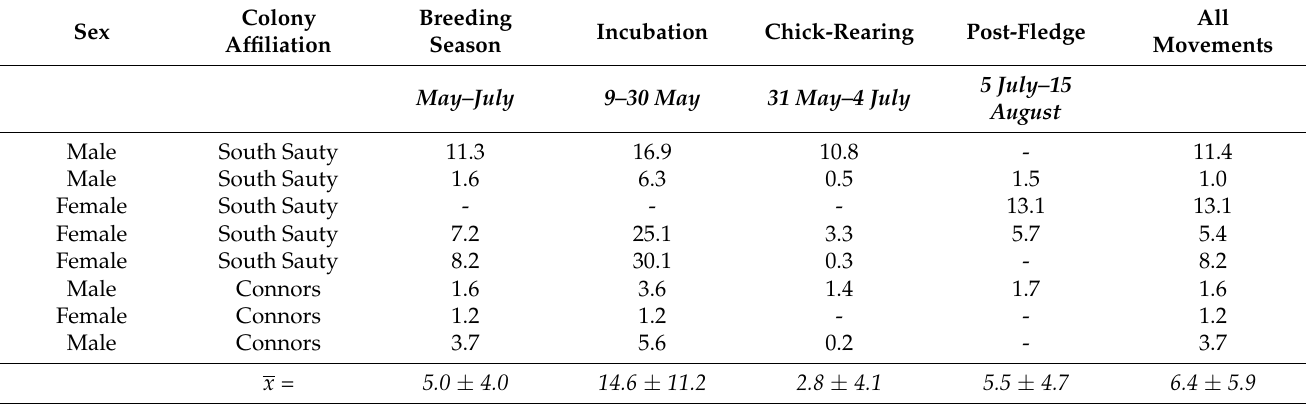
Table 3. Fifty percent home ranges (km 2 ) measured for all movements of Double-crested Cormorants ( n = 8 birds) in Guntersville Reservoir, Alabama in 2017. Breeding season ( n = 7) is incubation ( n = 6) and chick-rearing periods ( n = 6), combined. Post-fledge ( n = 4), colony affiliation refers to a nesting site. Dashes indicate no data for that time period.